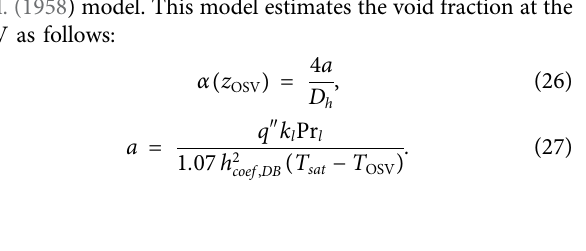
Frontiers in Energy Research |